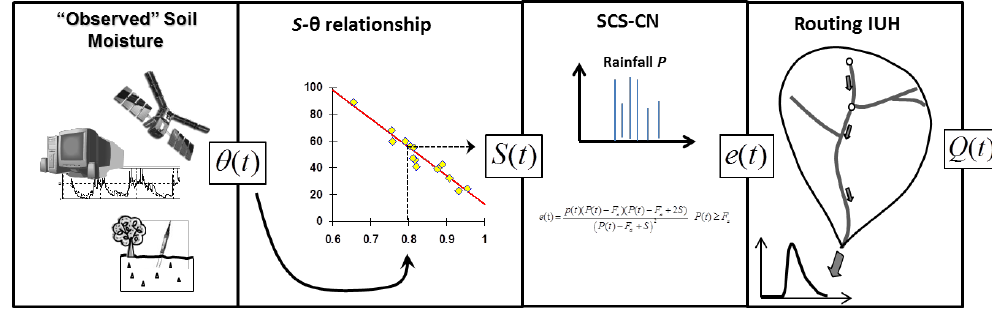
Fig. 3. Structure of the Simplified Continuous RR Model